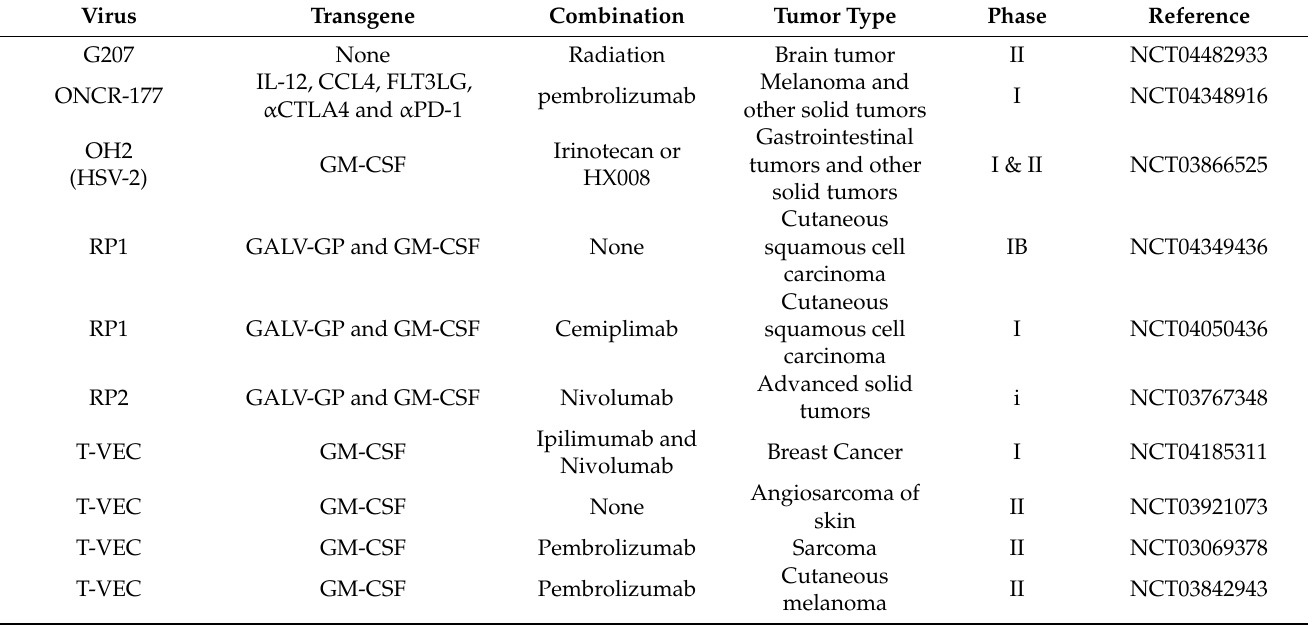
Table 1. Examples of oncolytic herpes simplex viruses (HSVs) currently under clinical trials.